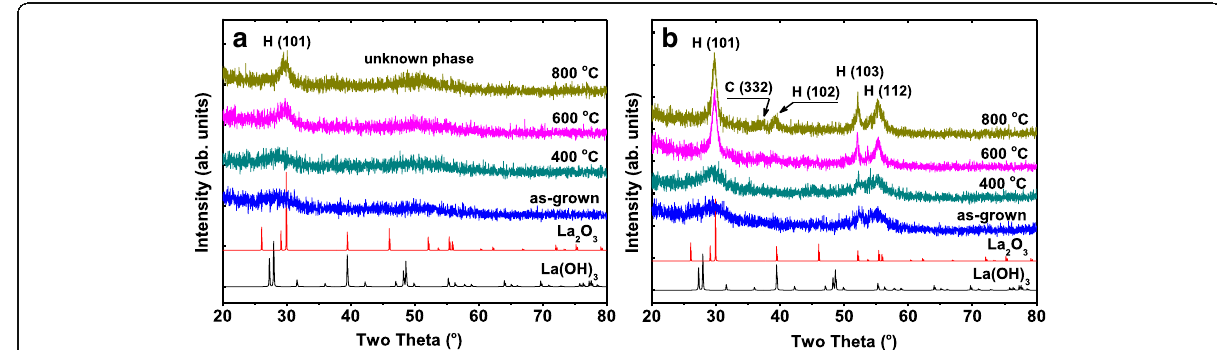
Fig. 1 GIXRD diffractograms of as-grown and annealed La 2 O 3 films deposited on Si substrate. a 10 and b 20 nm La 2 O 3 films. Hexagonal La 2 O 3 and hexagonal La(OH) 3 patterns are added for